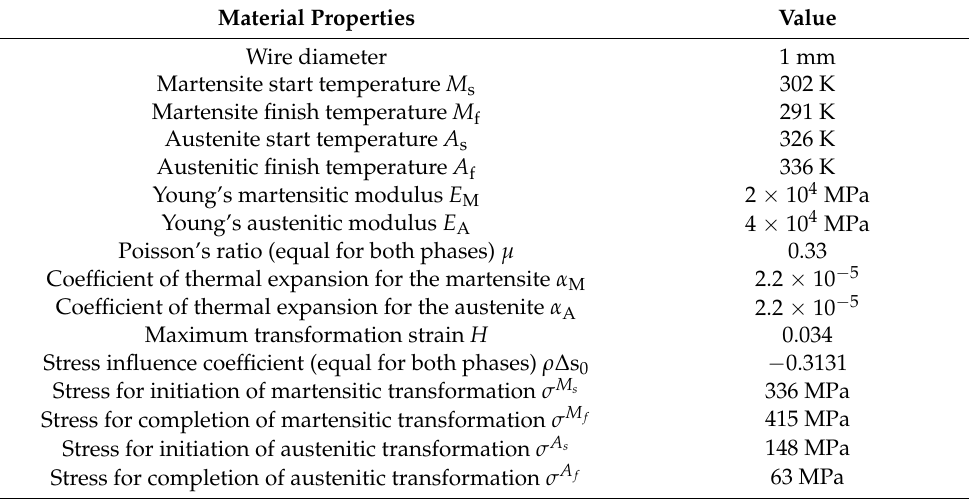
Figure 2. The calculated and experimental stress – strain correlations of SMA wire. Table 1. Material properties for SMA wire.